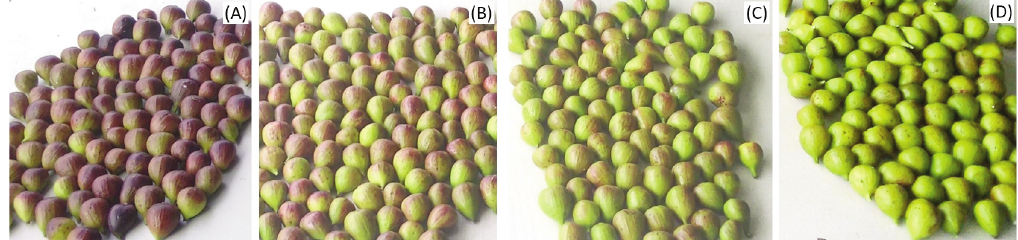
Fig. 1 ­ Figs of Roxo­de­Valinhos harvested at different stages of ripening. A ­ Advanced maturation; B ­ Maturation at 50% change skin color; C ­ Maturation at 25% change skin color, D ­ Maturation at 10% change skin